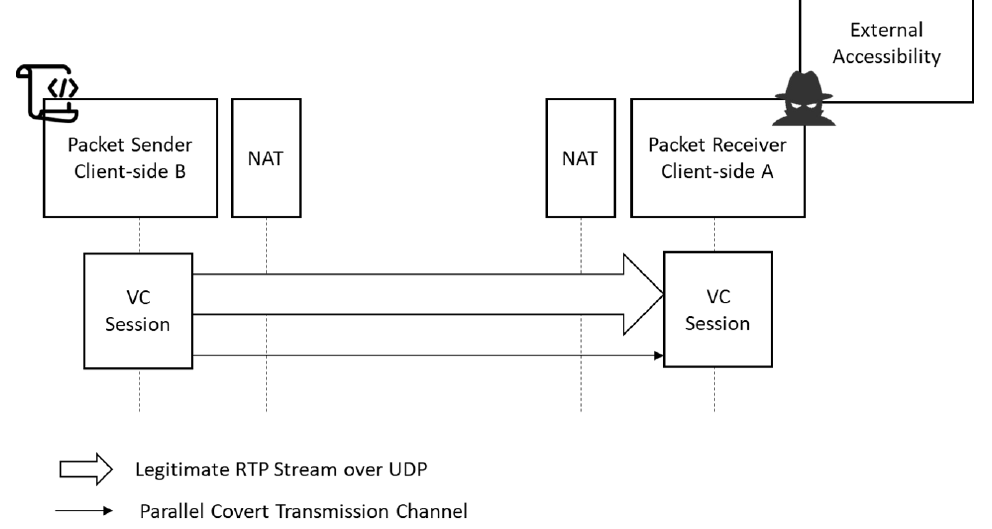
Figure 1. Graphical illustration: Parallel covert transmission channel in a point-to-point